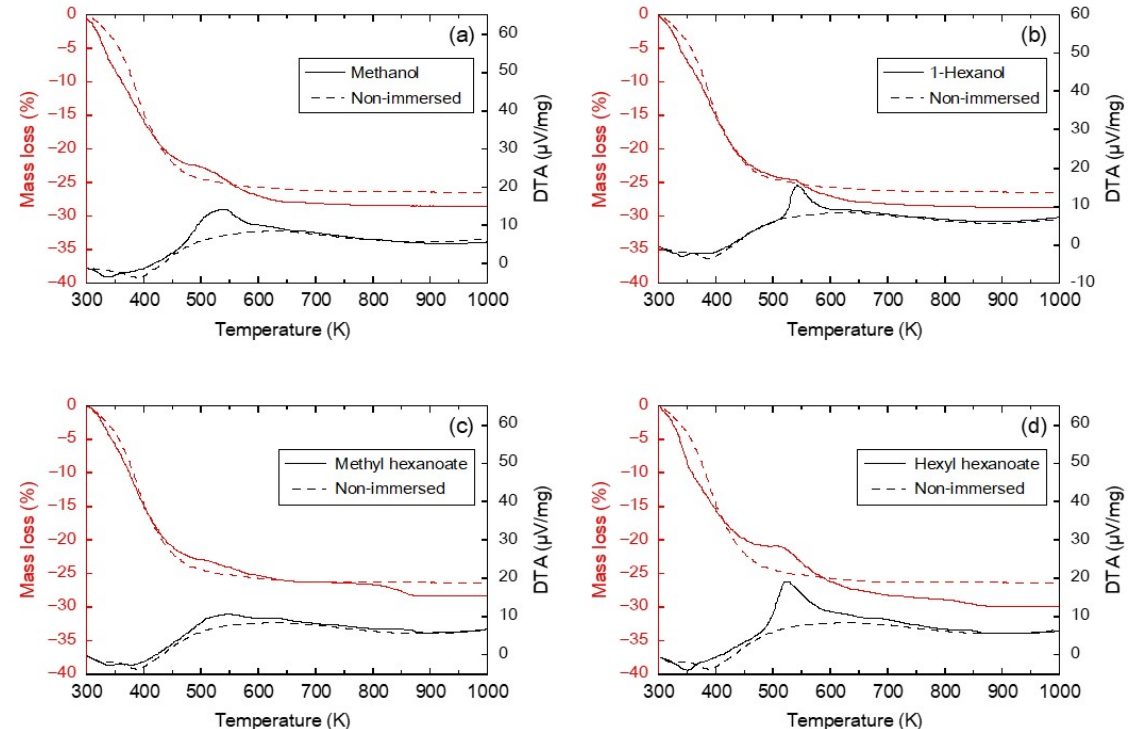
Figure 3. Thermal analysis of the FAU powder after immersion treatments in ( a ) methanol, ( b ) 1- hexanol, ( c ) methyl hexanoate, and ( d ) hexyl hexanoate. Non-immersed lines represent as a reference (dotted curves). The temperature ramp rate was 5 K min − 1 and the feed was 100 mL min − 1 air.